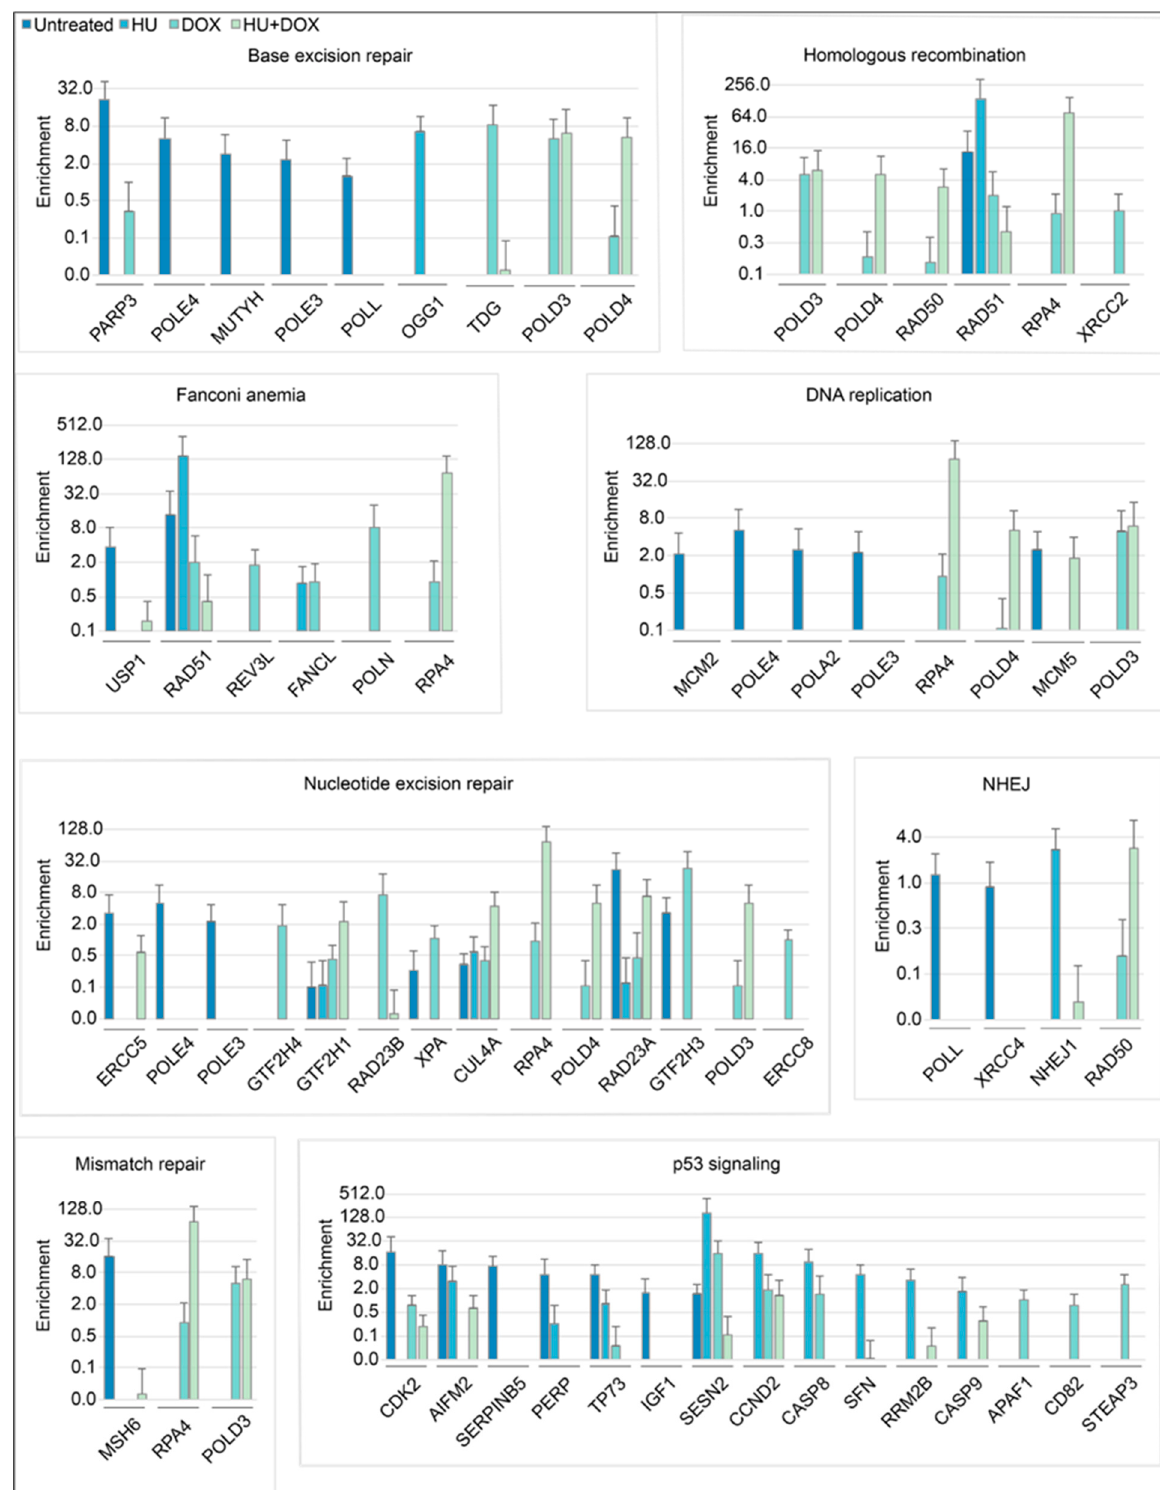
Figure 4. KEGG pathway loci involved in DNA replication, repair, and signaling that were detected in the shRNA screen. If more than one shRNA targeting the same locus was identified in a given treatment, the one with the highest enrichment is presented. The legend for the graphs is at the top left. (n = 4 replicates per treatment, FDR ≤ 0.001).